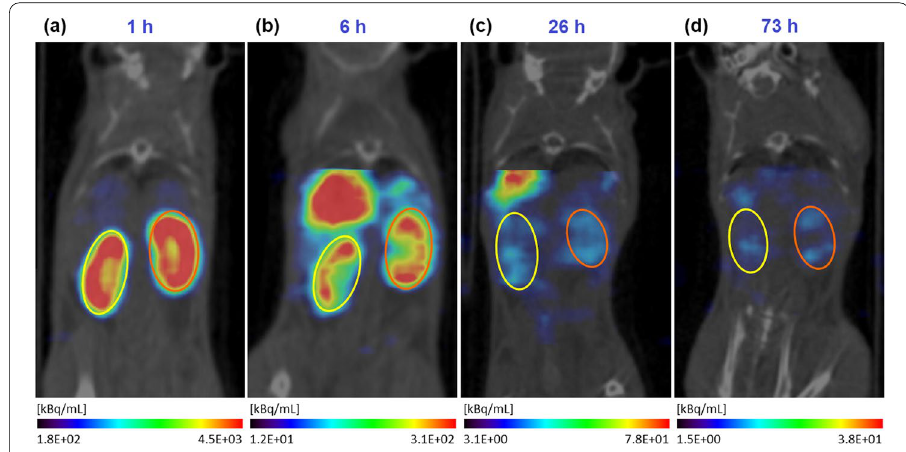
Fig. 5 Overlays of SPECT and CT section images through the kidneys, sequentially acquired in vivo on the mouse of dataset LS5, at around 1 ( a ), 6 ( b ), 26 ( c ) and 73 ( d ) h p.i. of the [ 131 I]-sdAb. VOIs used for activity quantification are shown in each sub-figure as an overlay in yellow (left kidney) and orange (right kidney) colours. High uptake above left kidney of sub-figures ( b ) and ( c ) corresponds to liver tissue. To enhance the visibility of kidney tissues, the activity concentration data of each sub-figure is scaled to 2% (minimum value) and 50% (maximum value) of the maximum voxel value of the SPECT